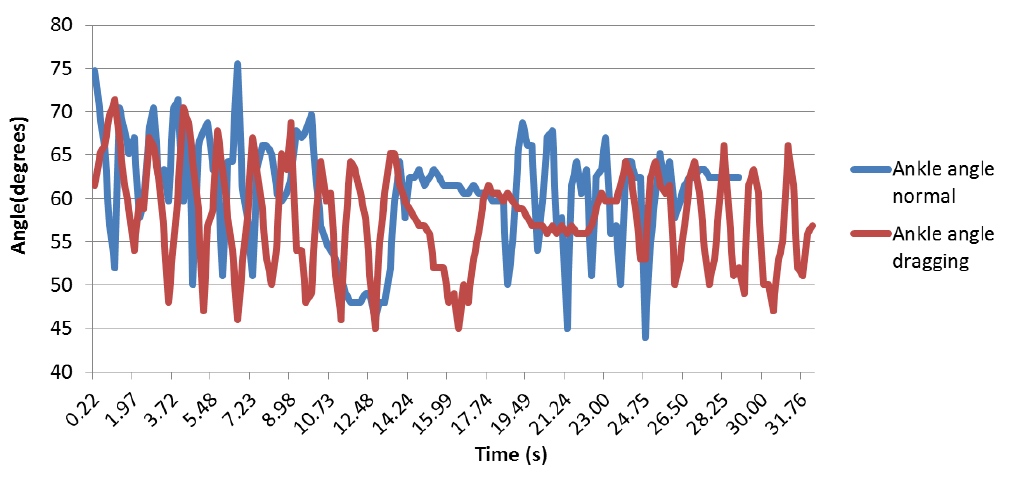
Figure 24. Ankle angle